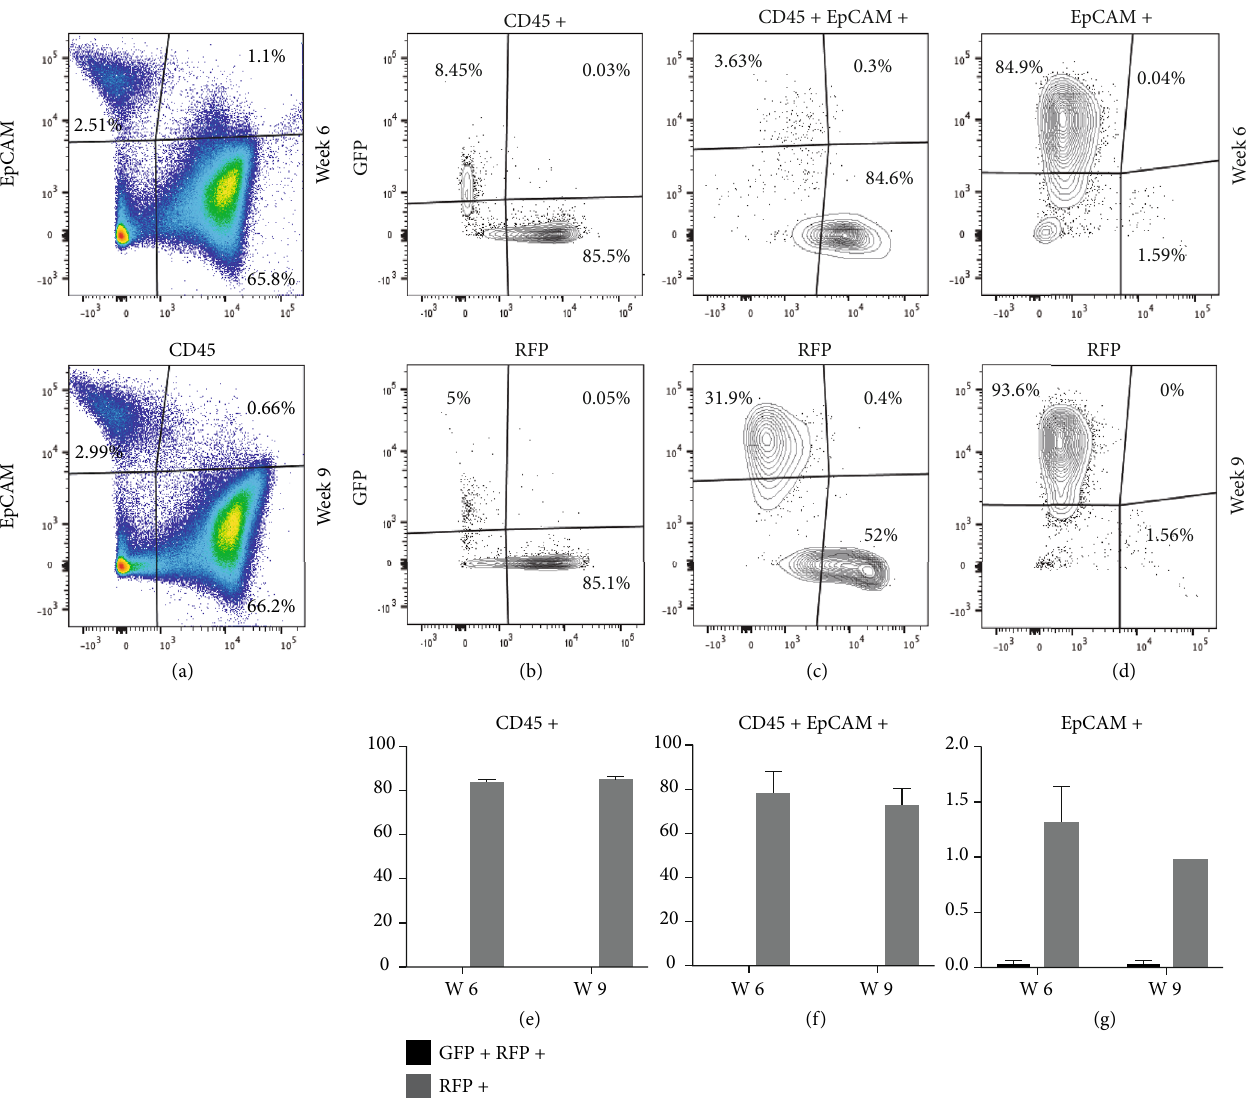
Figure 9: The CD45+ EpCAM+ and CD45- EpCAM+ TEC populations derived from peripheral cells are not a result of cell fusion. Actin H2B-GFP fetal thymuses were transplanted under the kidney capsule of mRFP Rosa26 mice and analyzed 6 and 9 weeks after transplant using FACS. All the experiments were done in triplicate. (a) The FACS representation of the lineage-depleted cells derived from dissociated engrafted thymi gated for CD45 and EpCAM. (b) The FACS representation of the percentage of GFP+-, GFP+ RFP+-, and RFP+-expressing cells within the CD45+ EpCAM- population at di ff erent time points. (c) The FACS representation of the percentage of GFP+-, GFP+ RFP+-, and RFP+-expressing cells within the CD45+ EpCAM+ population at di ff erent time points. (d) The FACS representation of the percentage of GFP+-, GFP+ RFP+-, and RFP+-expressing cells within the CD45- EpCAM+ population at di ff erent time points. (e) Bar graph showing the mean percentage of the CD45+ GFP+ RFP+ (potential cell fusions) and CD45+ RFP+ (peripheral cells) populations at di ff erent time-points (error bars represent SEM). (f) Bar graph showing the mean percentages of the CD45+ EpCAM+ GFP+ RFP+ (potential cell fusions) and CD45+ EpCAM+ RFP+ (peripheral cells) populations at di ff erent time points (error bars represent SEM). (g) Bar graph showing the percentages of the EpCAM+ GFP+ RFP+ (potential cell fusions) and EpCAM+ RFP+ (peripheral cells) cell populations at di ff erent time points (error bars represent